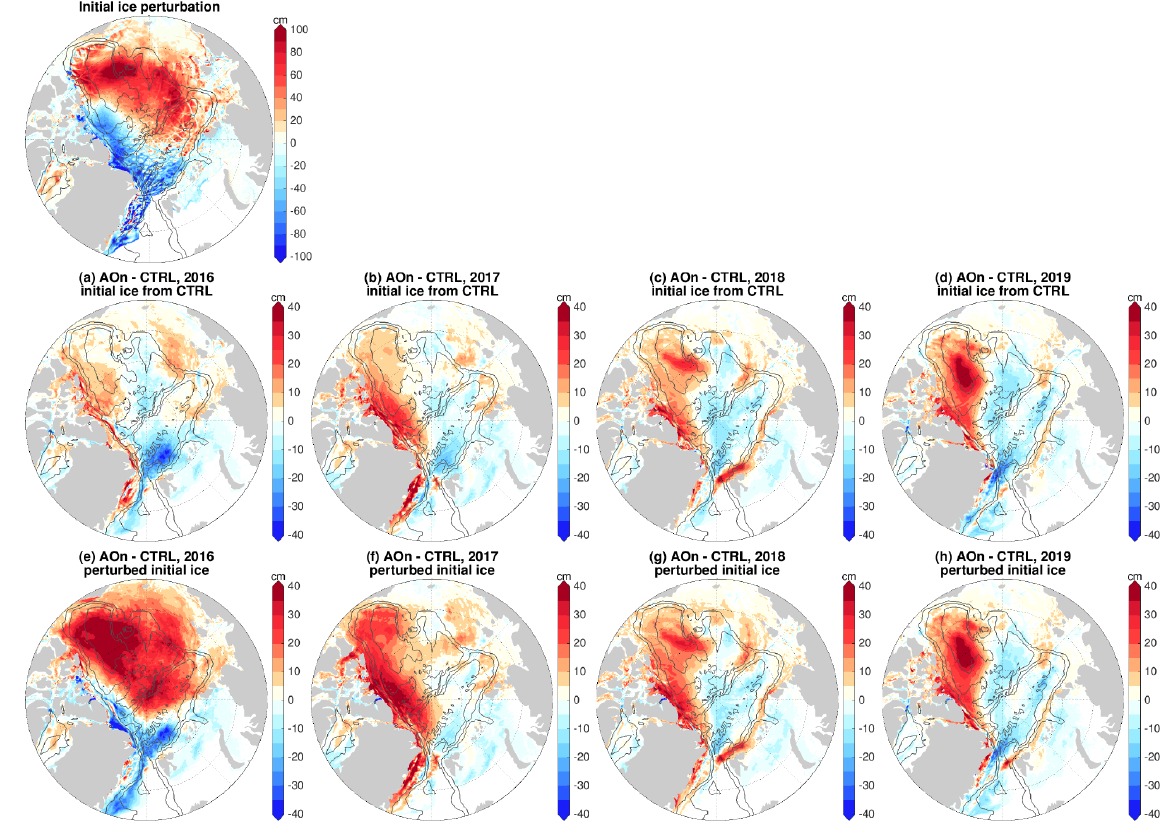
Figure 12. Impacts of sea ice initial condition versus ocean initial condition. Anomaly of sea ice thickness in the sensitivity experiment with only the initial ocean perturbed by applying the negative phase of Arctic Oscillation (AO) perturbation beforehand: in (a) 2016, (b) 2017, (c) 2018 and (d) 2019. The anomalies are referenced to the control run. (e–h) The same as (a–d) , but for the experiment with initial sea ice also perturbed. In this experiment, the initial sea ice at the beginning of 2016 is taken from that at the end of the spinup run with negative AO. The difference in the initial sea ice thickness between the two simulations is shown at the top of the figure. Comparing (a) – (d) with (e) – (h) indicates that the impact of the initial ocean condition overwhelms the impact of the initial sea ice condition starting from the third year. The black contour lines indicate the 500, 2000 and 3500m